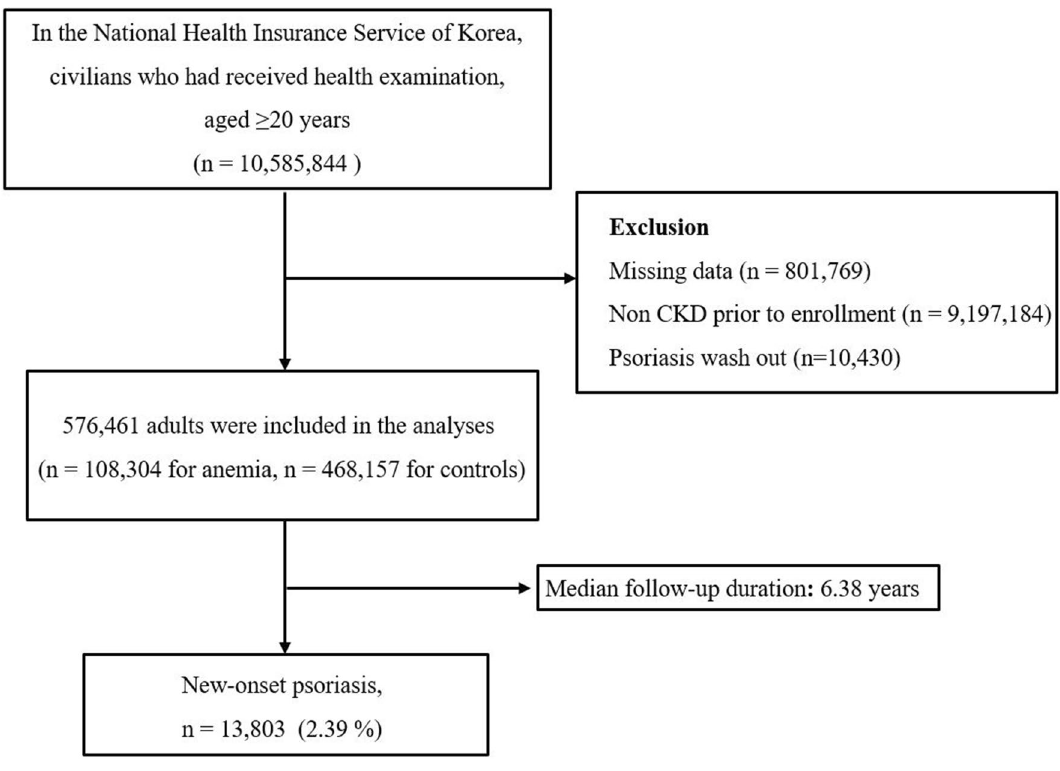
Figure 3. Flow chart of enrolled